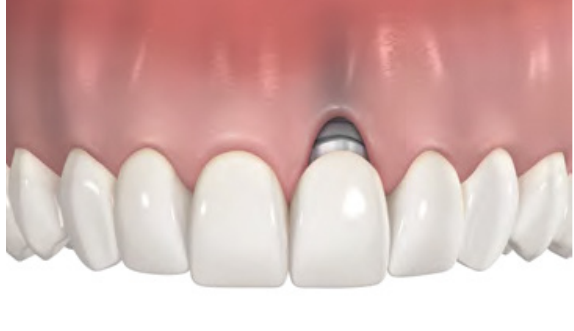
Figure 1. Clinical alterations in an implant placed in the anterior